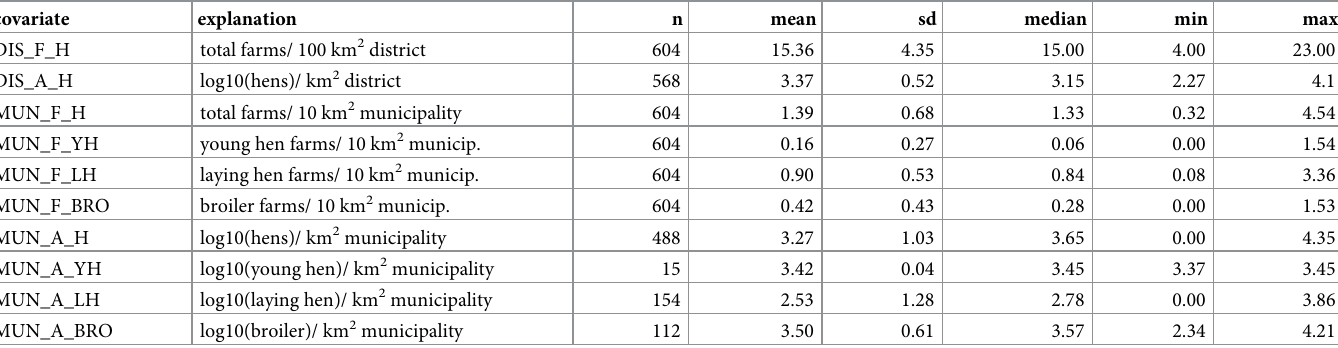
Table 2. Variables of farm and poultry density used for modeling the seropositivity in pheasants. covariate